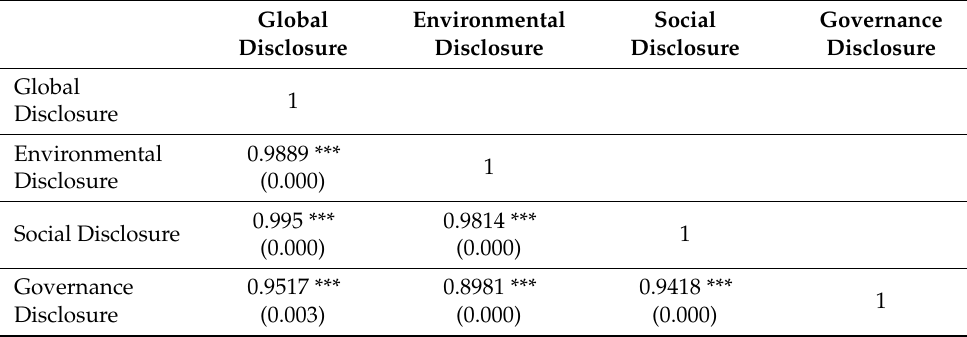
Table 4. Pairwise correlations of ESG disclosure